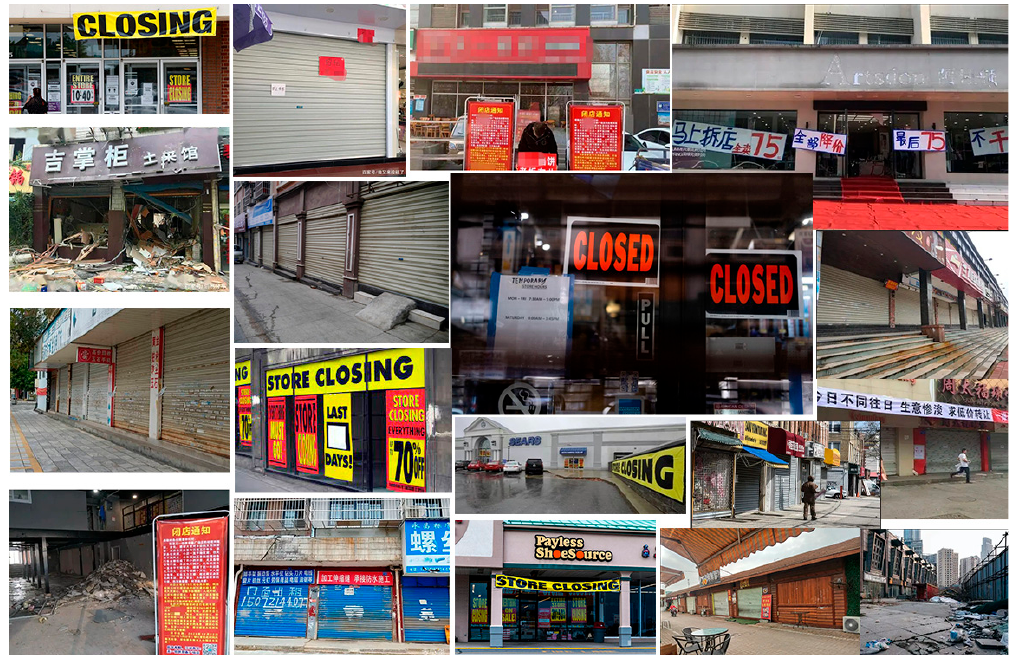
Figure 1. A large number of stores are closed in the global commercial